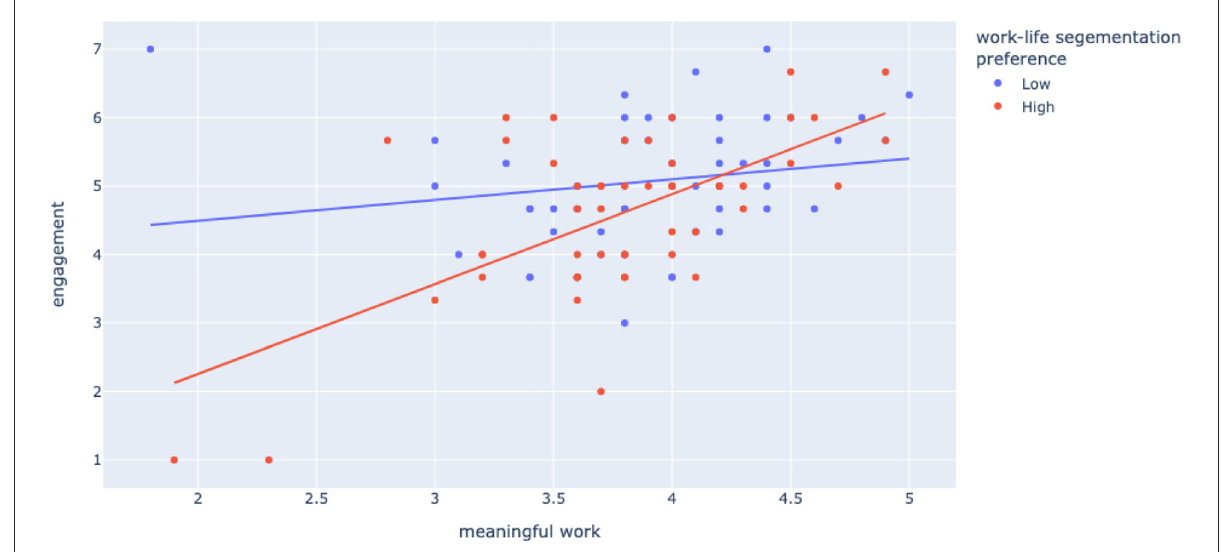
FIGURE1 Moderation meaningful work × engagement by work–life segmentation preference.